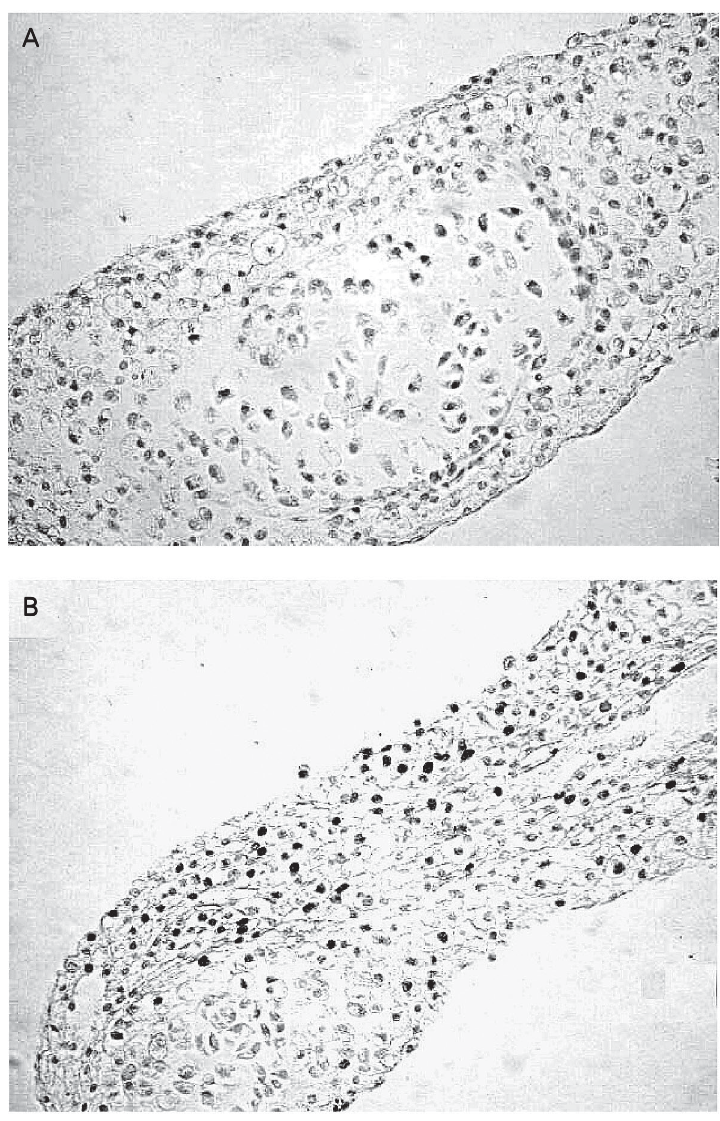
Figure 2. Analysis of cell proliferation of chick limb mesenchyme. In later stages (day 21), when cell matu- ration prevails over cell proliferation, the number of proliferating cells positively stained for proliferating cell nuclear antigen (PCNA) gradually diminished in 1% FCS control cultures (A). In insulin-treated cultures a high number of proliferating cells (dark cells) persisted up to day 21 (B). PCNA immunohistochemistry coun- terstained with Mayer’s hematoxylin. Final magnifica- tion: 10X (A and